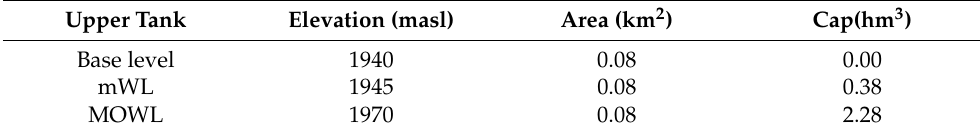
Table 4. Upper Tank Elevations-Capacities-Areas Curve.